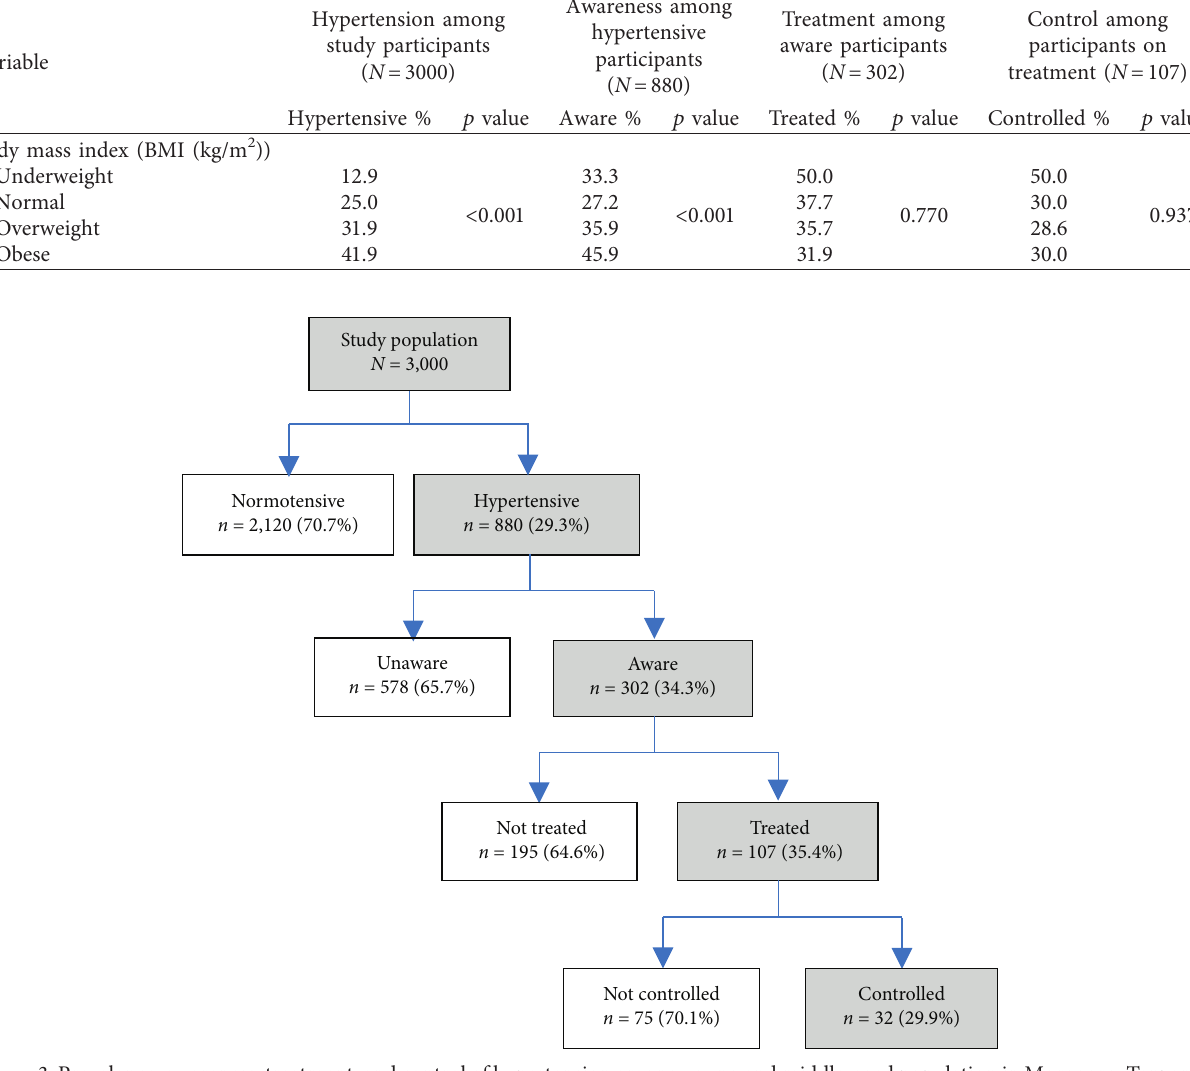
Figure 3: Prevalence, awareness, treatment, and control of hypertension among young and middle-aged population in Morogoro,